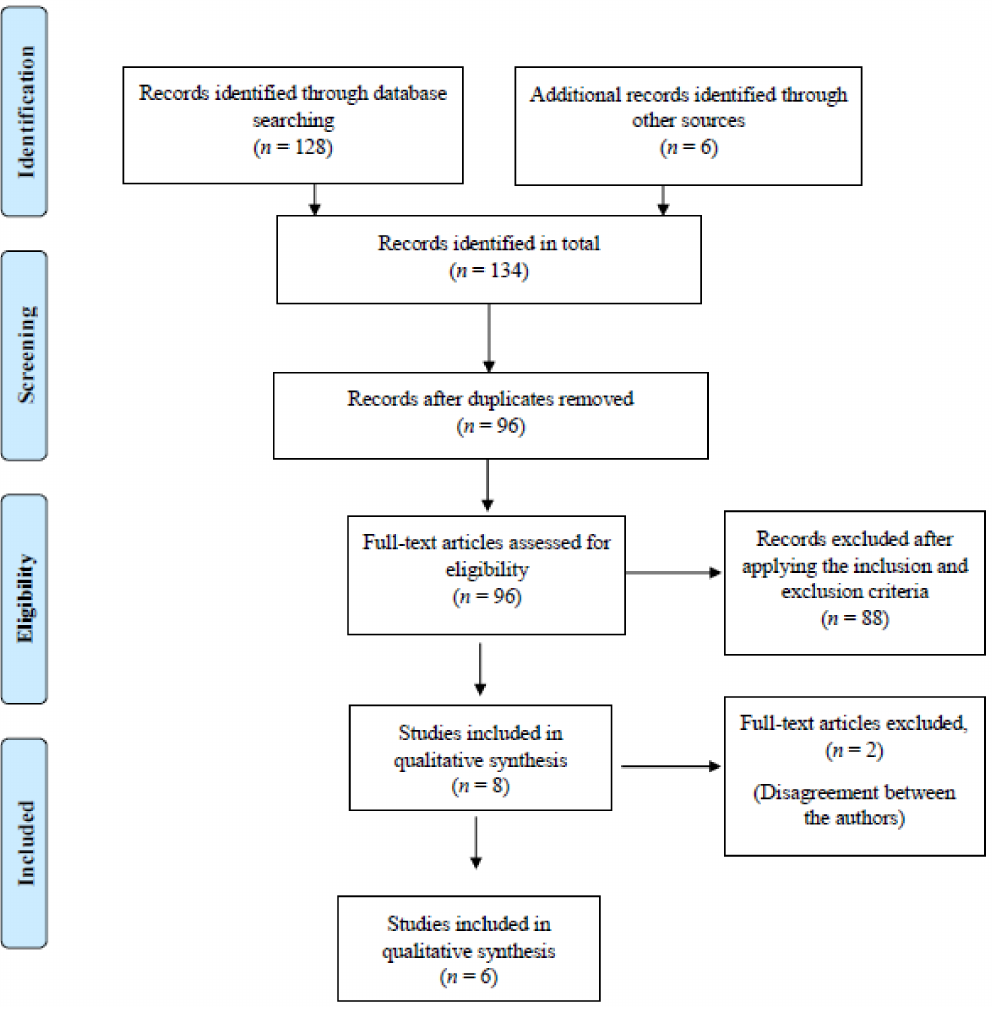
Figure 1. Flowchart for screening and selection of